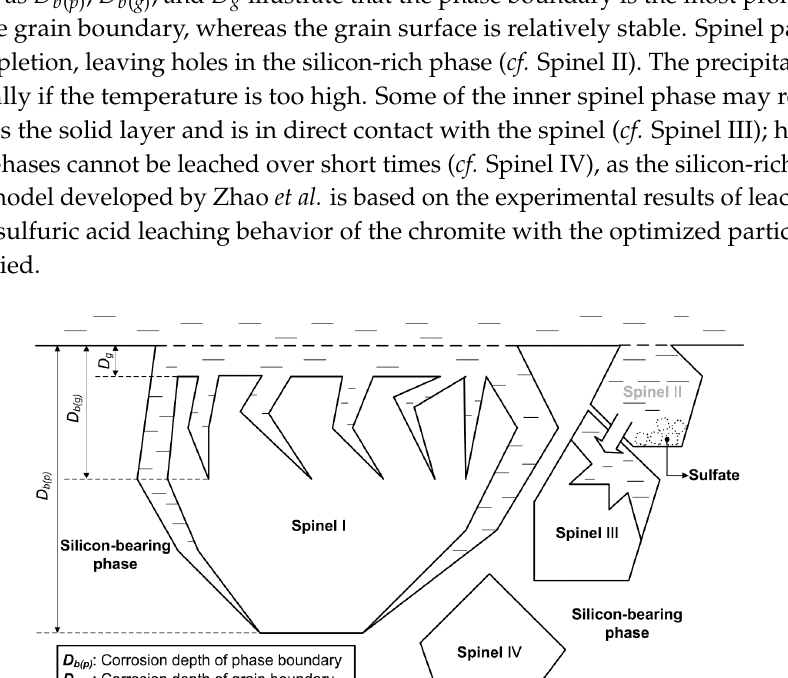
Figure 3. Leaching mechanism of chromite with sulfuric acid [57].